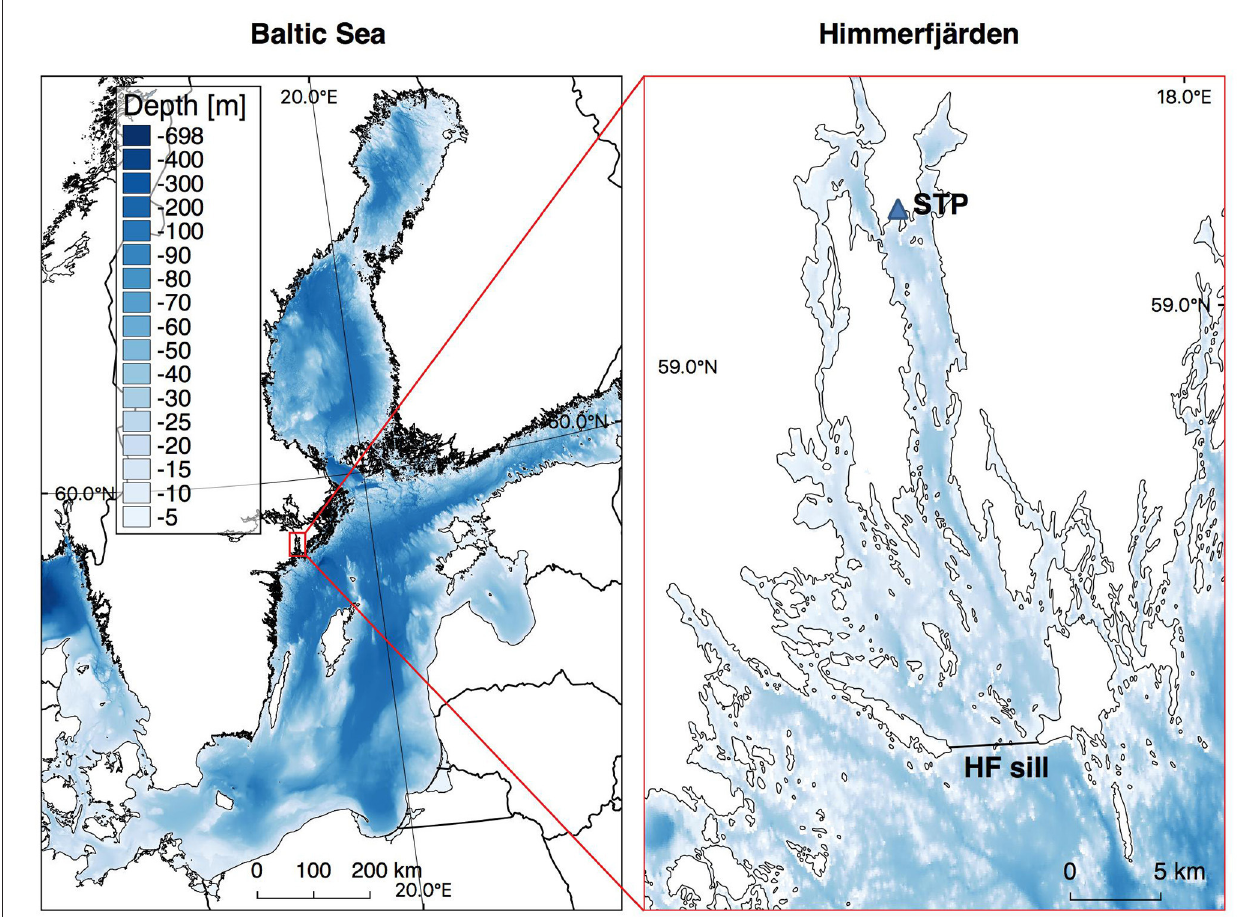
FIGURE 1 | Area of investigation. Baltic Sea and Himmerfjaäden bay (HF), Swedish coastal areas. STP: Sewage Treatment Plant. Bathymetry data (Shom, 2018); (http://portal.emodnet-bathymetry.eu/). European coastline shapefile (European Environment Agency; https://www.eea.europa.eu/ds_resolveuid/ 06227e40310045408ac8be0d469e1189). Country boundaries (Natural Earth; https://www.naturalearthdata.com/downloads/10m-cultural-vectors/10m-admin-0-